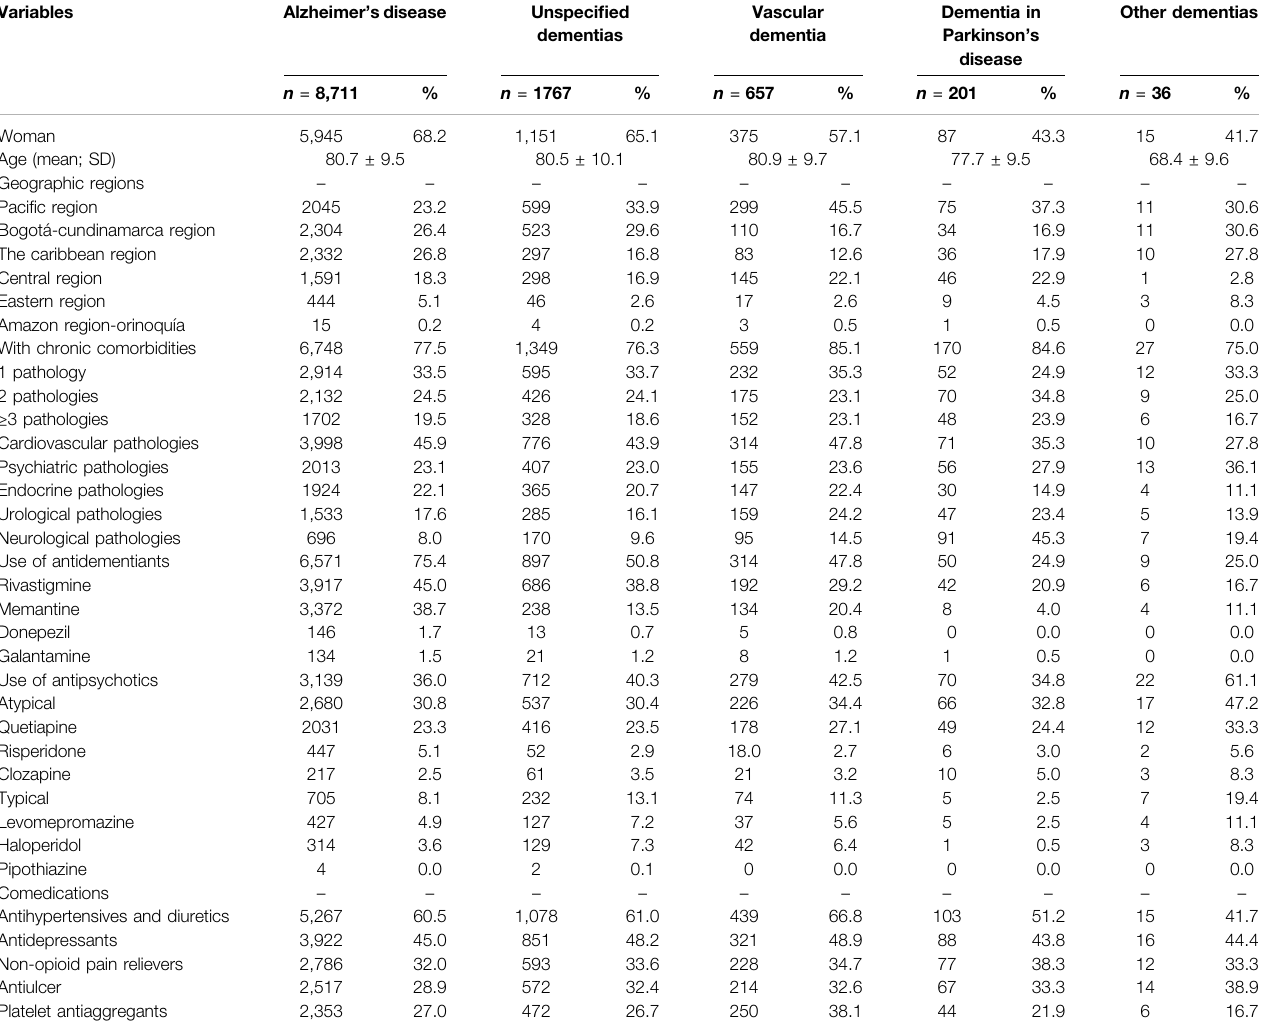
TABLE 2 | Comparison of sociodemographic, clinical and pharmacological variables with types of dementia in a group of patients in Colombia, 2019.